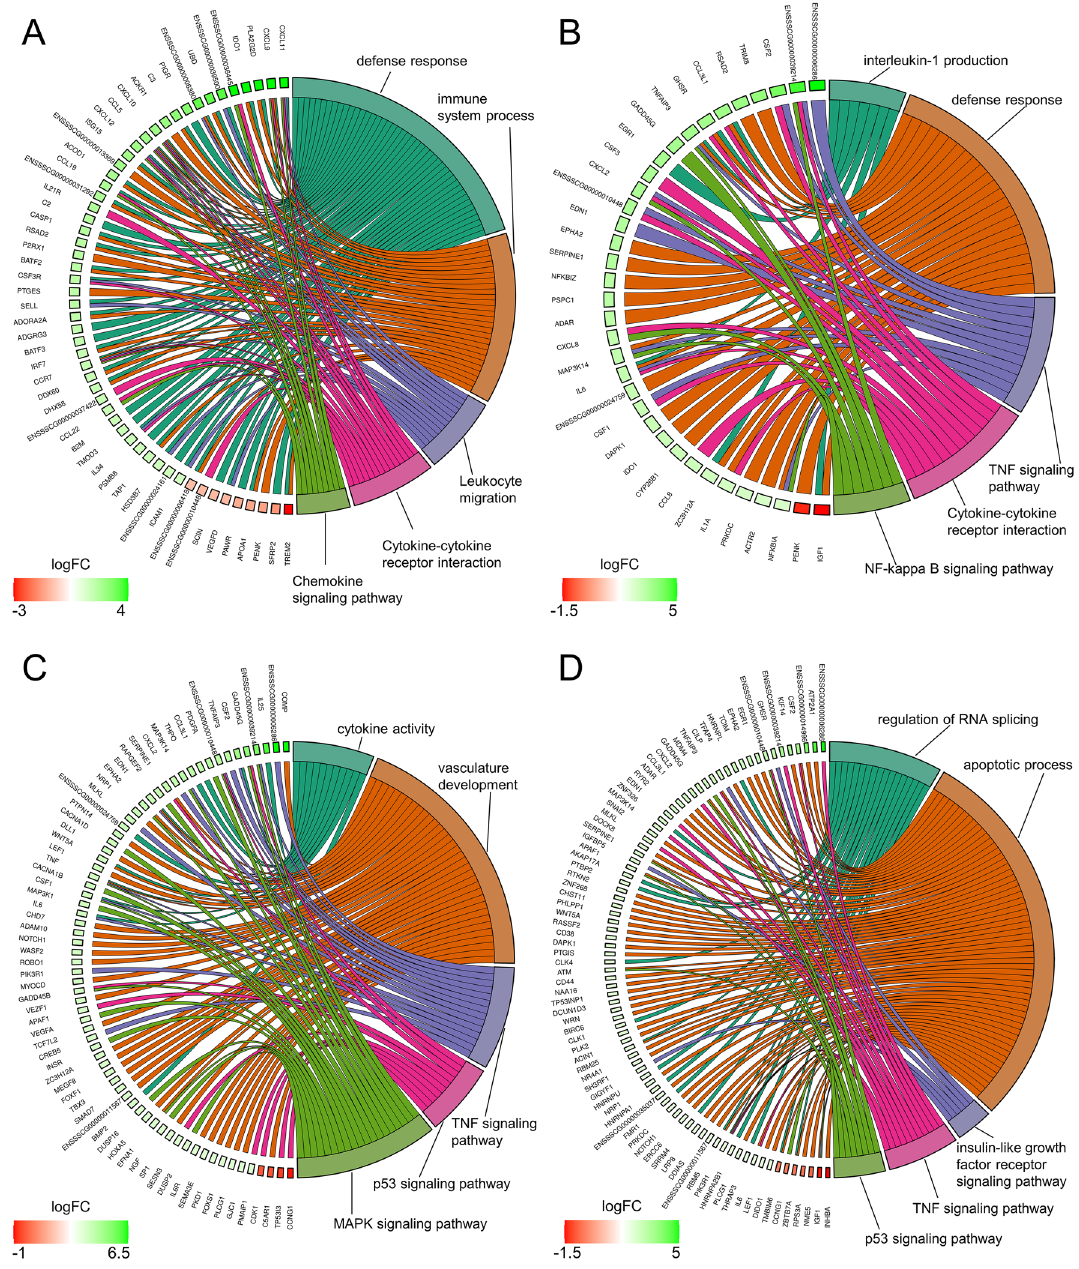
Figure 3. Circos plots presenting selected Gene Ontology processes and KEGG pathways associated with differentially expressed genes (DEGs) engaged in the responses to LPS ( A ), PPARγ agonists PGJ 2 ( B ) or pioglitazone ( C ) and antagonist ( D ) in endometrial tissue. Logarithmic values (blue-red scale) represent the fold change (logFC) of DEGs. Five-color links combine gene symbols (left) with the most important GO and KEGG annotations (right). The plots were generated in the GOplot R bioconductor